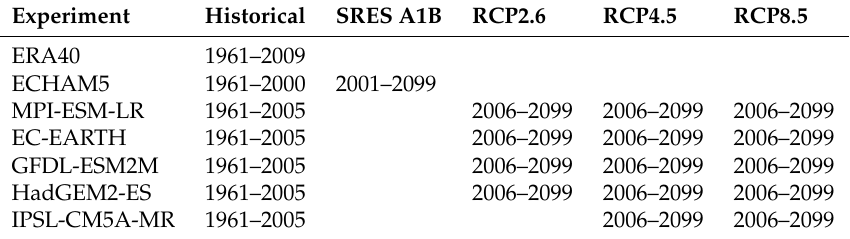
Table 1. List of hindcast and scenario experiments conducted with RCA4-NEMO.